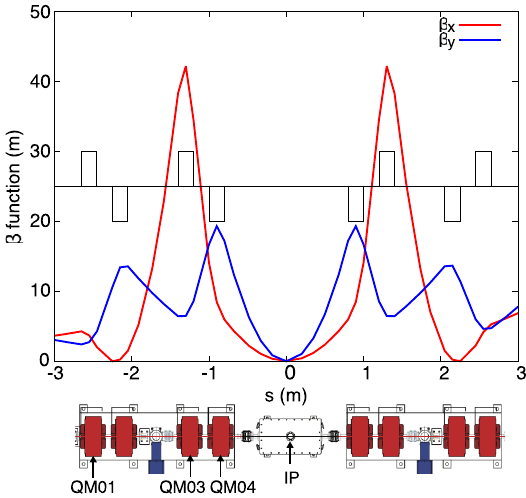
FIG. 5. Beam envelopes designed to obtain a tight focused electron beam at the IP, β (cid:3) x ¼ 0 . 11 m and β (cid:3) y ¼ 0 . 037 m.